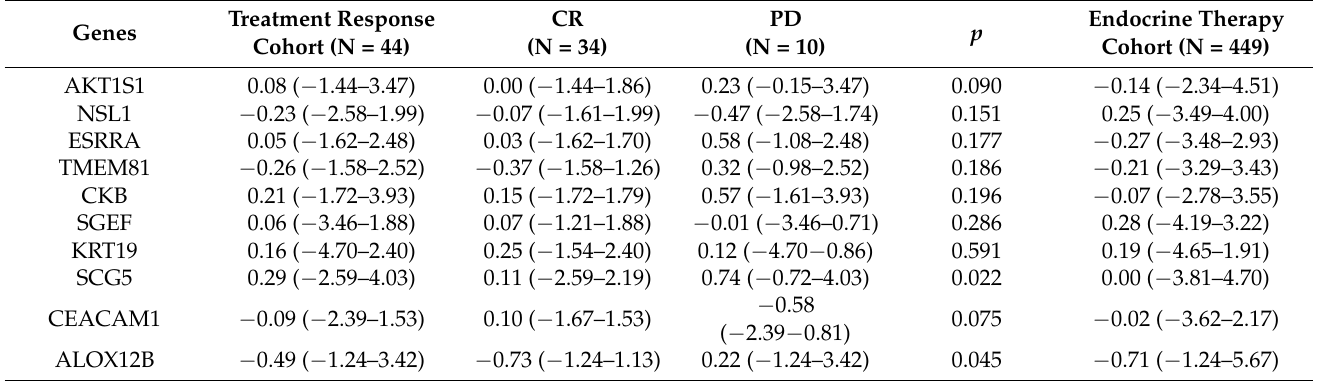
Table 6. The RNA-seq expression with reads per kilobase million (RPKM) of candidate genes in the treatment response and endocrine therapy